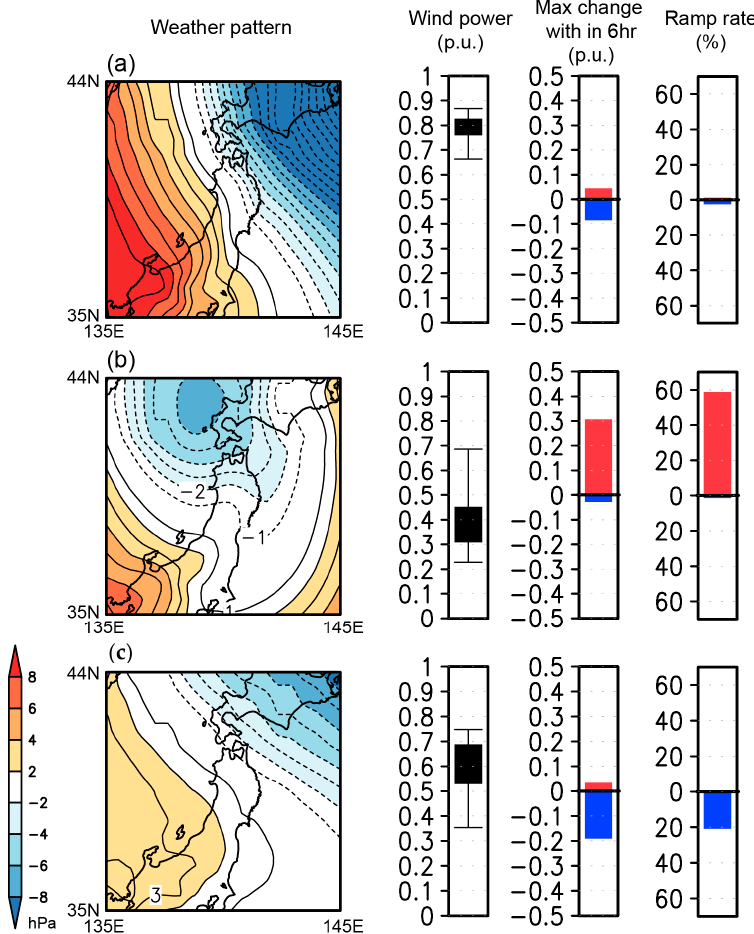
Figure 3. ( a – c ) Three examples of WPs (SLP) derived from the 50 × 50 SOM nonlinear classification (hPa: red and blue shading). Right panels show the WP-related wind power generation (p.u. black error bar for fifth, 25th, 75th, and 95th percentiles), frequency occurrence rate (%) of ramp-up (red) and ramp-down (blue), and maximum up (red) and down (blue) of wind power generation (p.u.) over ≤ 6 h for each SOM node.